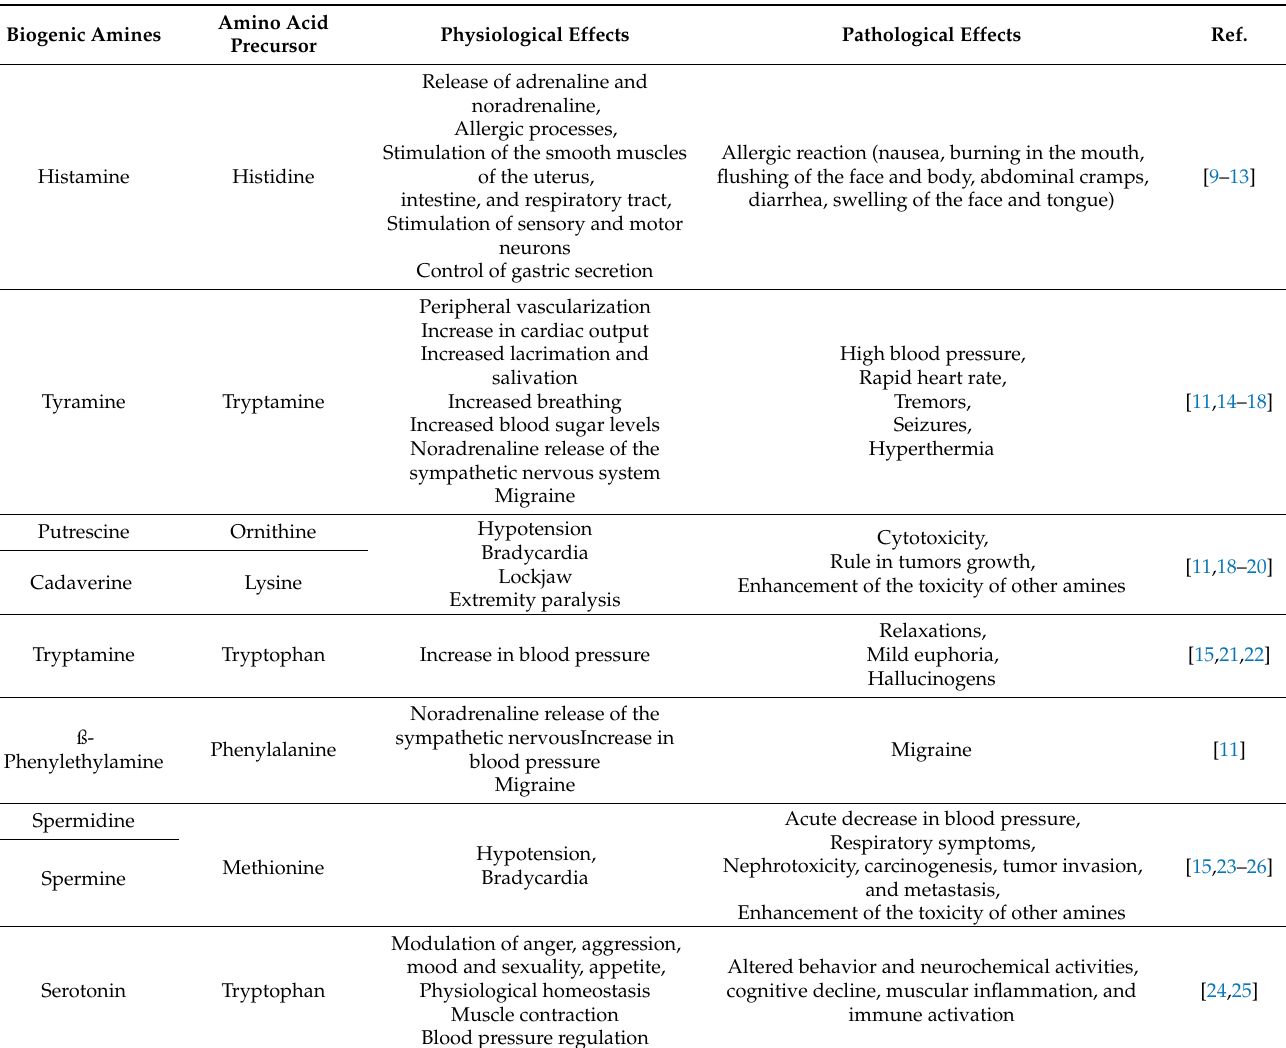
Table 1. Physiological and pathological effects of the major BAs in